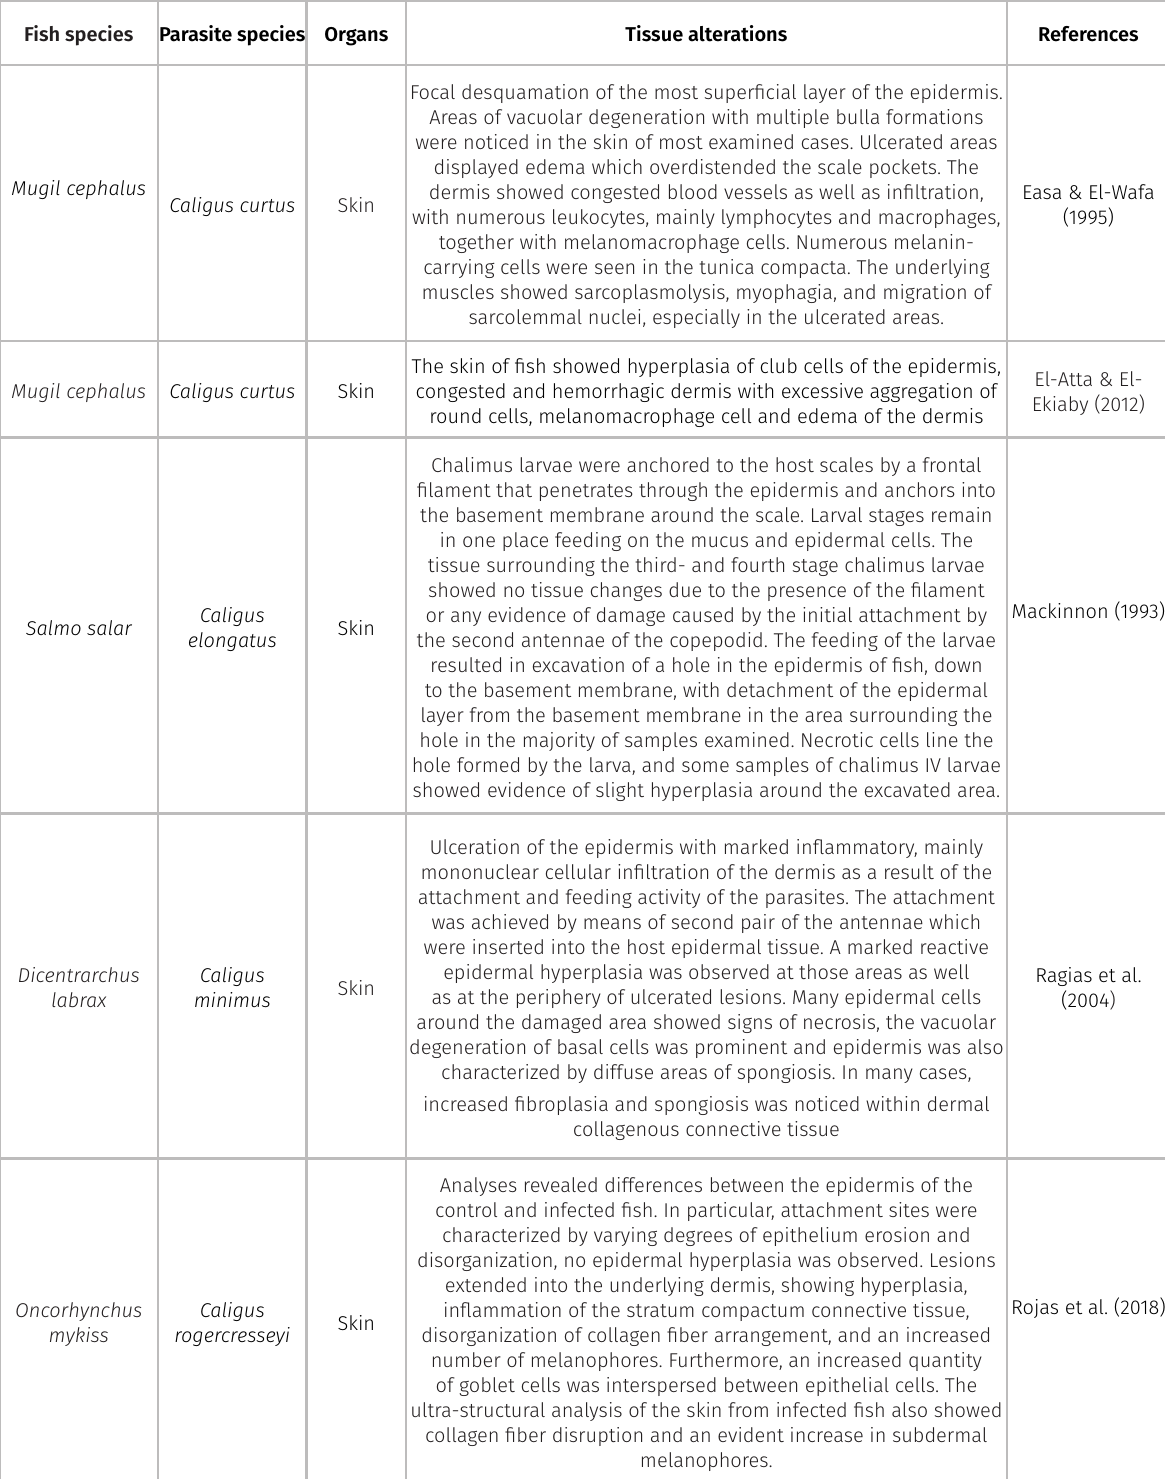
Table II. Histopathological alteration caused by infestation of Caligus spp. in different teleost species. Fish